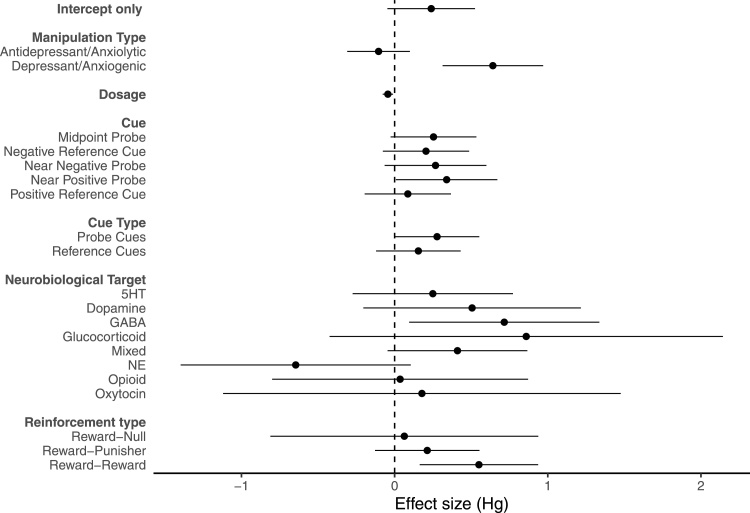
Forest plot with a meta-analytic mean (intercept-only model) and significant moderators from univariate meta-regression models. Each point represents the mean effect size for each moderator and error bars represent the 95% confidence interval.